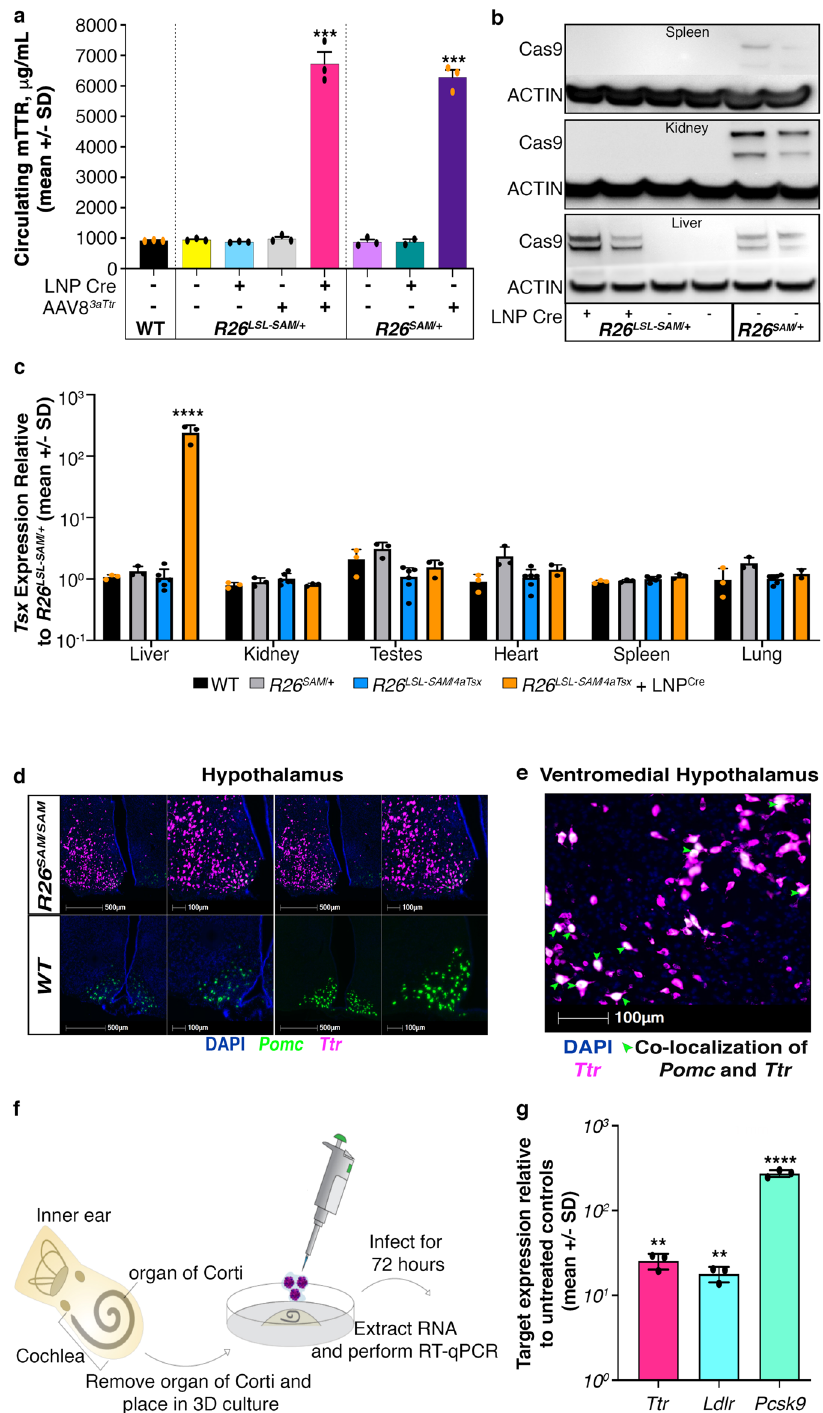
Fig. 4 Tissue-speci fi c overexpression in vivo. a LNP Cre was delivered to R26 LSL - SAM / + to activate SAM expression in the liver ( n = 3); data was plotted as the mean per group + / − SD. p -values of each comparison can be found in Supplementary Table 4. Three replicates were conducted with similar results. b A western blot showing dCas9 SAM expression (219 kDa) in R26 LSL - SAM / + tissues treated with LNP Cre . dCas9 SAM signals are normalized to actin (41 kDa). One repeat was completed with similar results. c Expression pro fi le of Tsx in R26 LSL - SAM / 4aTsx tissues with and without LNP Cre treatment. Tsx expression relative to R26 SAM / + was determined by RT-qPCR ( n = 3) and plotted as the mean per group + / − SD; p = 0.000082. d RNAscope of hypothalamus sections showing DAPI (blue), Pomc (green) and Ttr (magenta) in R26 SAM / + and WT mice ( n = 2). e Zoom of ventromedial hypothalamus showing co- localization of Pomc and Ttr . Green arrows are pointing to white patches that represent co-localization. Additional individual repeats have not been conducted. f Graphical protocol for harvest and culture of the organ of Corti. g RT-qPCR determination of Ttr ( p = 0.0015), Ldlr ( p = 0.001395), and Pcsk9 ( p = 0.000052) expression levels in organ of Corti explant cultures to R26 SAM /SAM . Results are plotted as the mean per group + / − SD ( n = 3). Asterisks (*) indicates signi fi cance, and the number of asterisks indicates the number of 0s after the decimal point. One-tailed, unpaired Student ’ s t -test for ( a , c , g